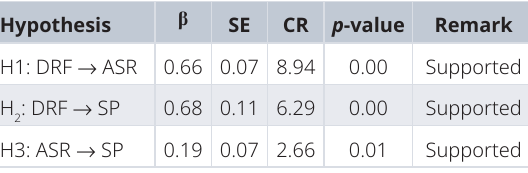
Table 6. Summary of hypotheses